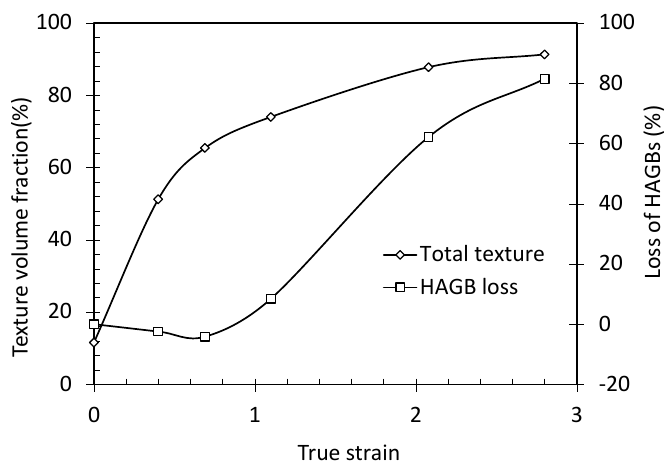
Figure 9. Overall texture volume fraction and the loss of lamellar HABs calculated according to the difference between the measured and geometrically predicted HAB spacing at 77 K.